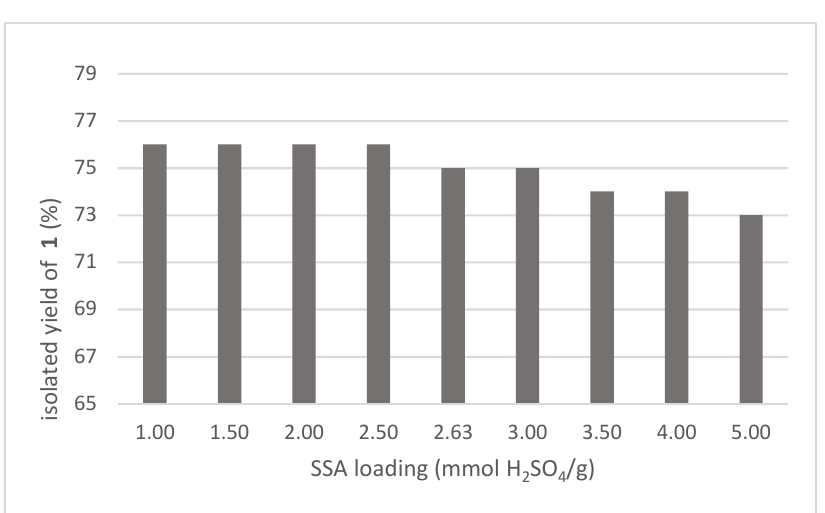
Figure 3. Performances of sulfuric acid adsorbed (SSA) with different H 2 SO 4 loading (1.5 mol% respect to gly